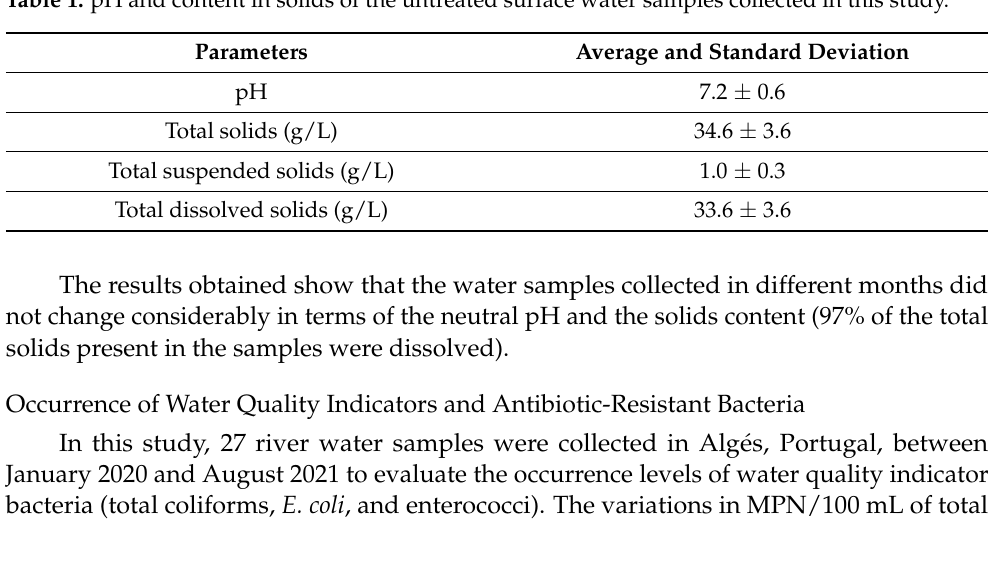
Table 1. pH and content in solids of the untreated surface water samples collected in this